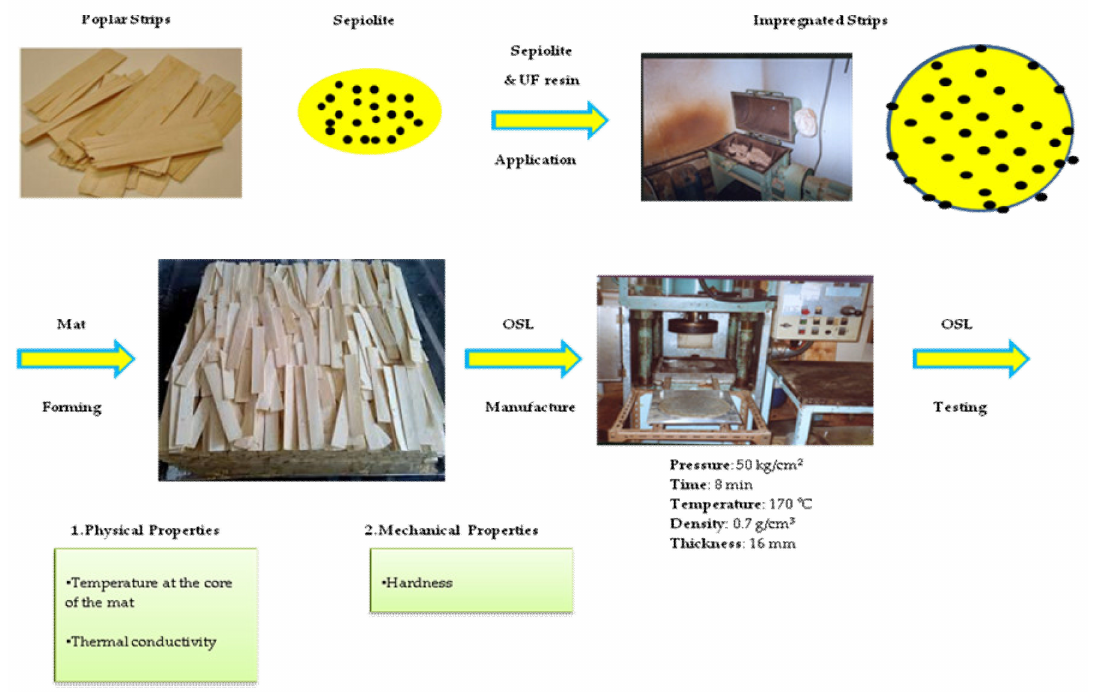
Figure 4. Flow diagram of the experimental